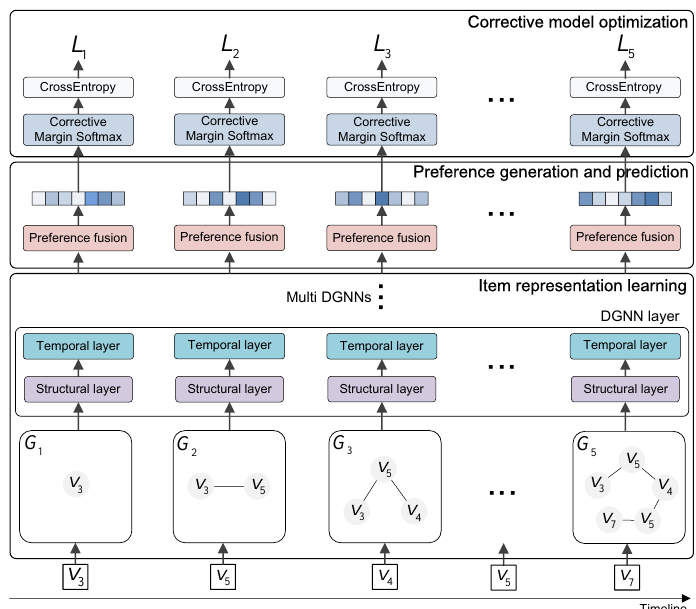
Figure 1. The framework of DGL-SR, which is constituted of three main components, that is, the dynamic item representation learning, the user preference generation and prediction, and the corrective model